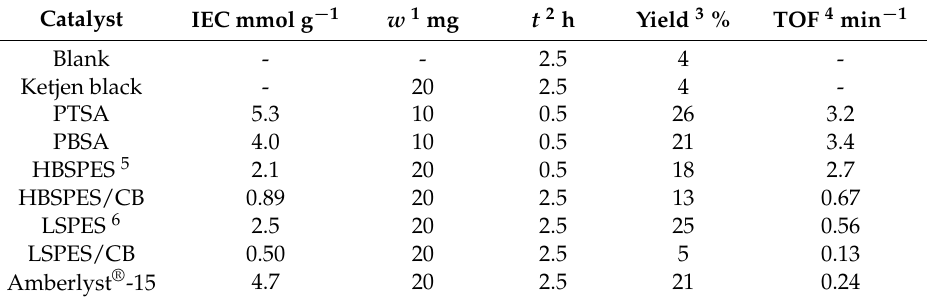
Table 1. Results of catalytic esterification reaction [9].